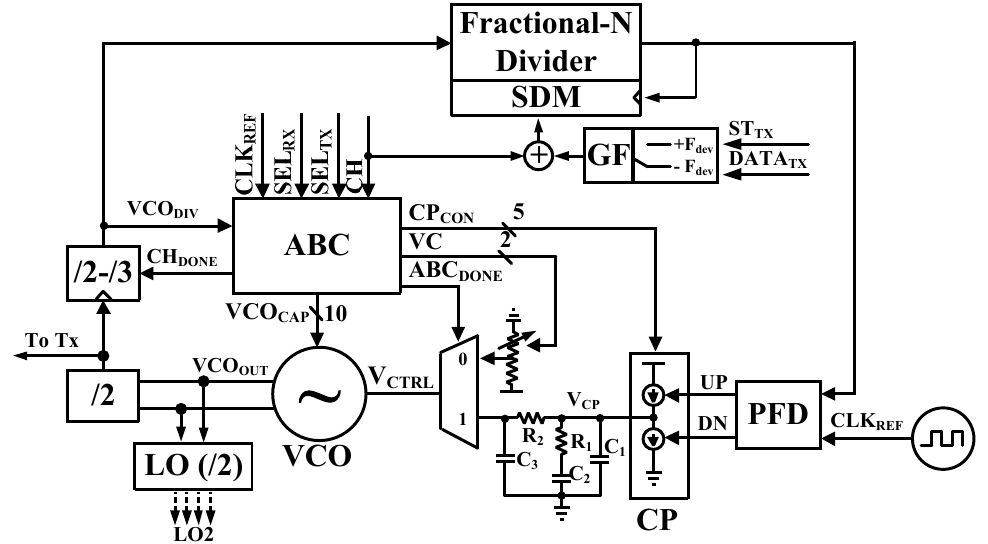
Figure 3. Block diagram of the analog phase-locked loop with automatic bandwidth calibration.